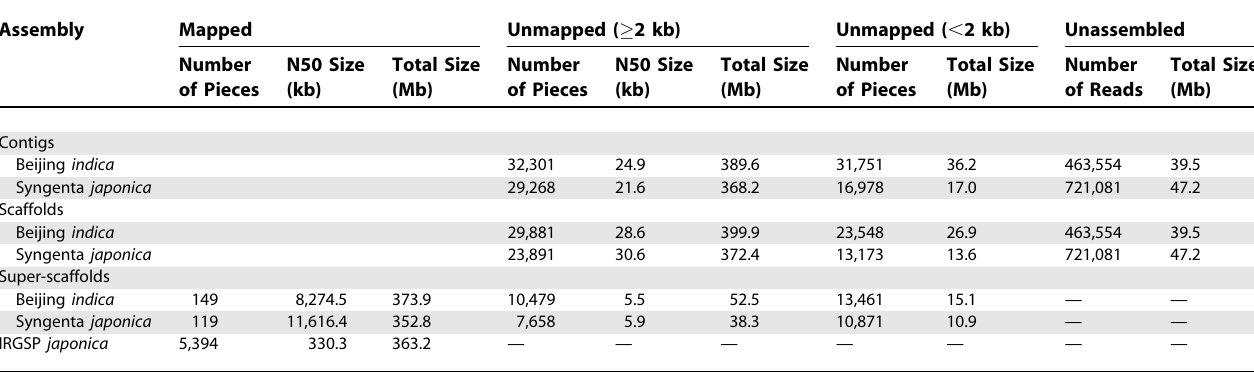
Table 1. Summary of Assembled Contigs, Scaffolds, and Super-Scaffolds Assembly